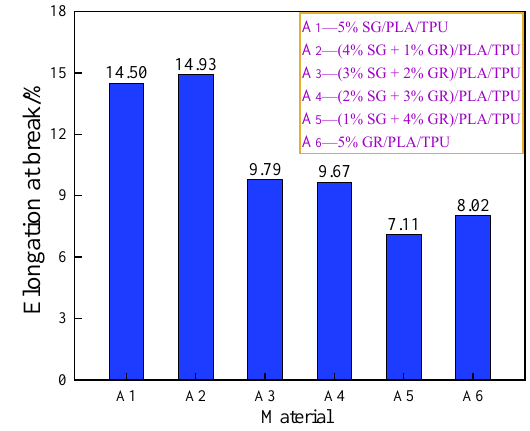
Figure 12. Elongation at break of A 1 ~A 6 composites.